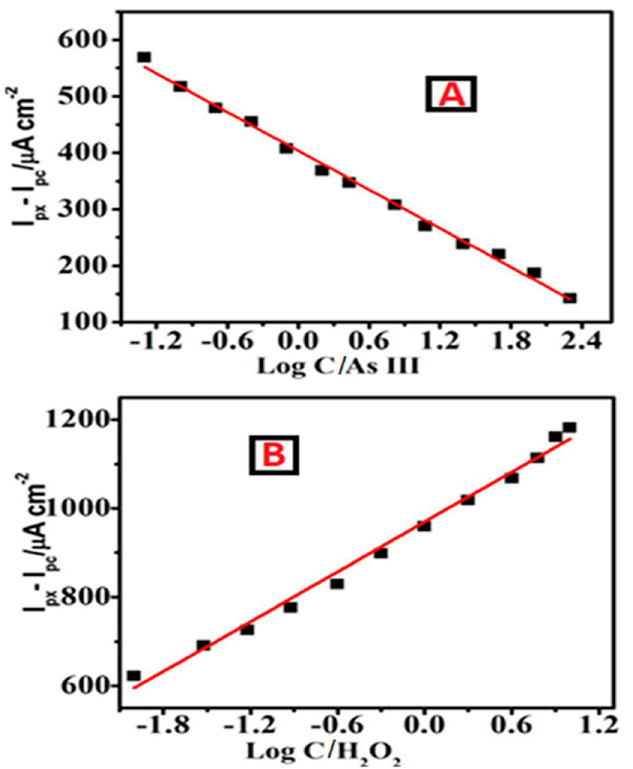
Figure 5. ( A ). Nyquist plot of the PB nanoparticle-modified electrode in the presence of varying concentrations of hydrogen peroxide. ( B ). Nyquist plot of the PB nanoparticle-modified electrode in the presence of varying concentrations of As(III).